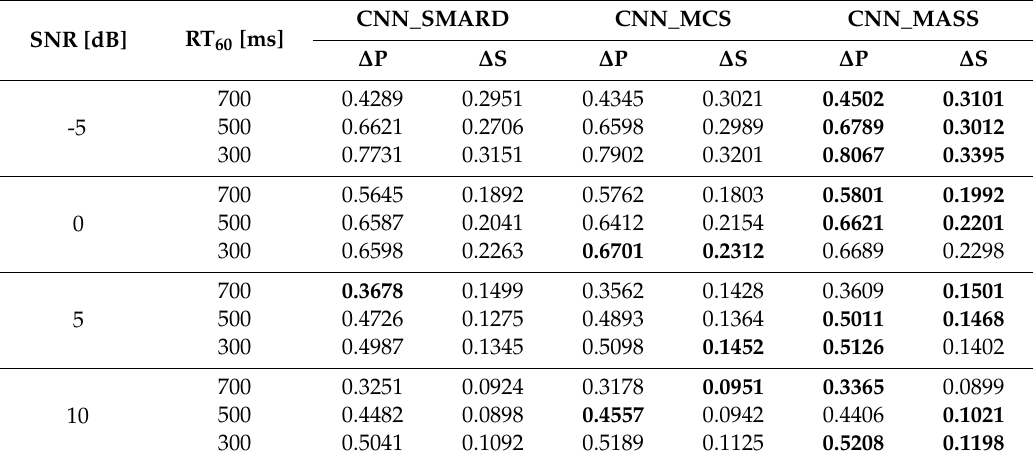
Table 3. The average improvement results in real speech data (The best performing methods are shown in